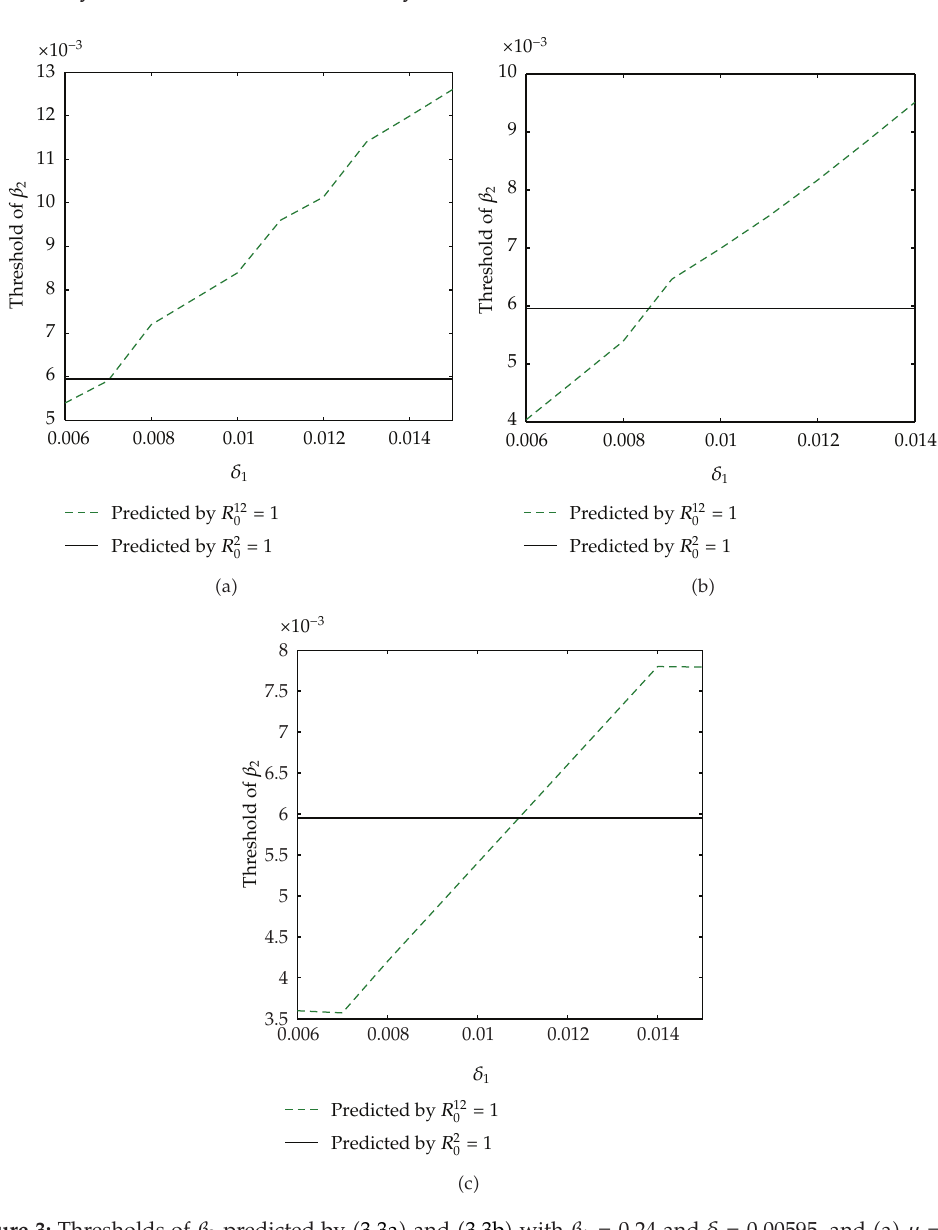
Figure 3: Thresholds of β 2 predicted by (cid:3) 3.3a (cid:4) and (cid:3) 3.3b (cid:4) with β 1 (cid:7) 0 . 24 and δ (cid:7) 0 . 00595, and (cid:3) a (cid:4) μ (cid:7) 1 . 2; (cid:3) b (cid:4) μ (cid:7) 1 . 5; (cid:3) c (cid:4) μ (cid:7) 2 are given. δ 1 is varied in the